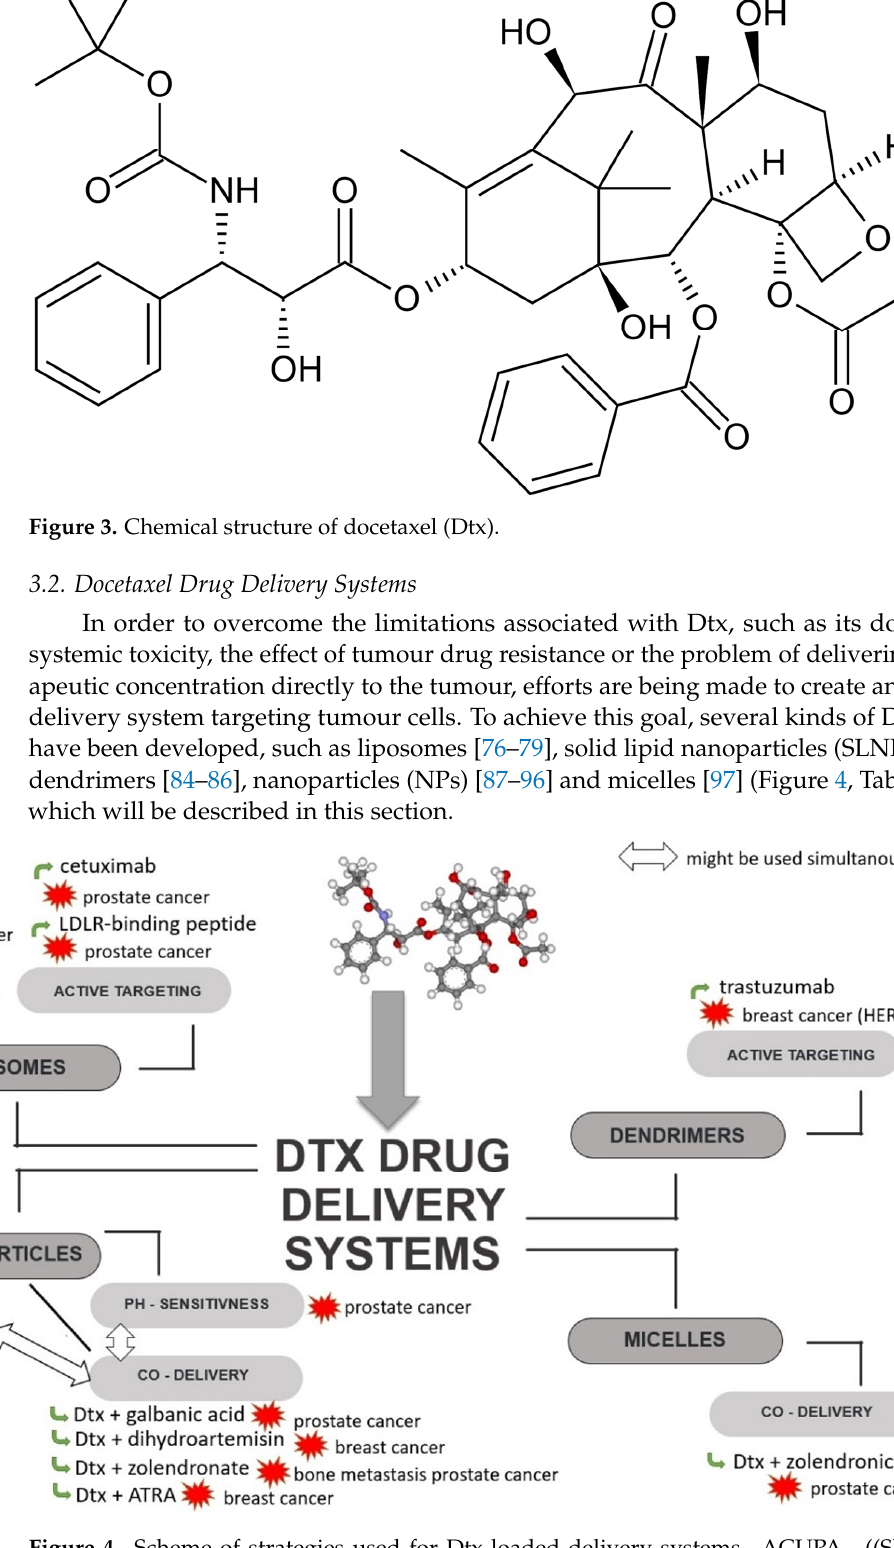
Figure 4. Scheme of strategies used for Dtx-loaded delivery systems. ACUPA—((S)-2-(3-((S)-5- amino-1-carboxypentyl) ureido) pentanedioic acid; ATRA—all-trans-retinoic acid; Dtx—docetaxel; HER—human epidermal growth factor receptor; LDLR—low-density lipoprotein receptor.